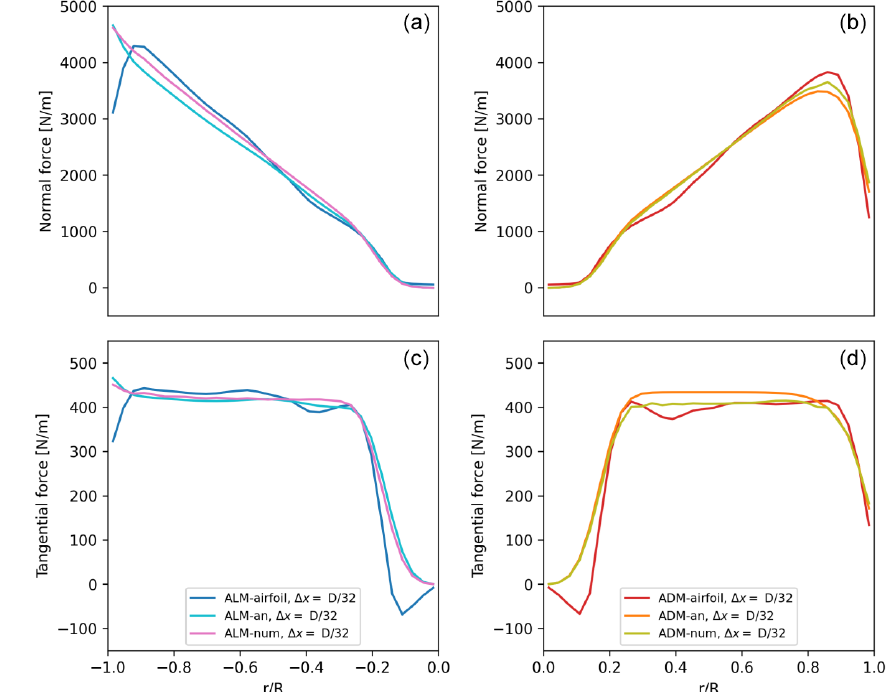
Figure 4. Model comparison for the single-turbine case under uniform velocity inflow conditions of U ∞ = 8ms − 1 and fixed conditions U ref = 8ms − 1 : normal f n (a, b) and tangential f θ (c, d) force distributions using different